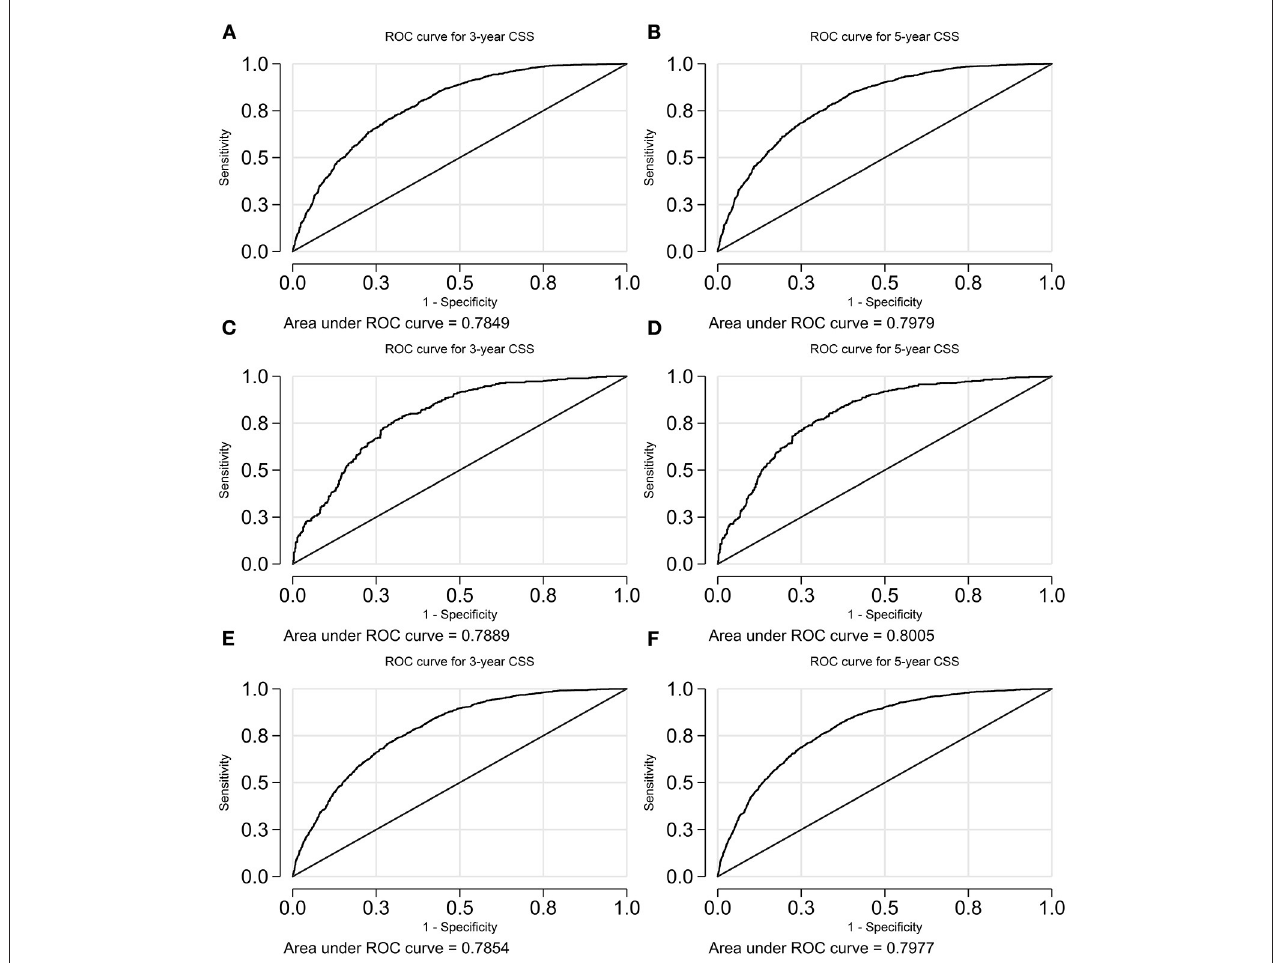
FIGURE 7 | A ROC curve of the model predicting CSS. (A) 3-years CSS in the training cohort; (B) 5-years CSS in the training cohort; (C) 3-years CSS in the validation cohort; (D) 5-years CSS in the validation cohort; (E) 3-years CSS in the overall cohort; and (F) 5-years CSS in the overall cohort. CSS, cancer-specific